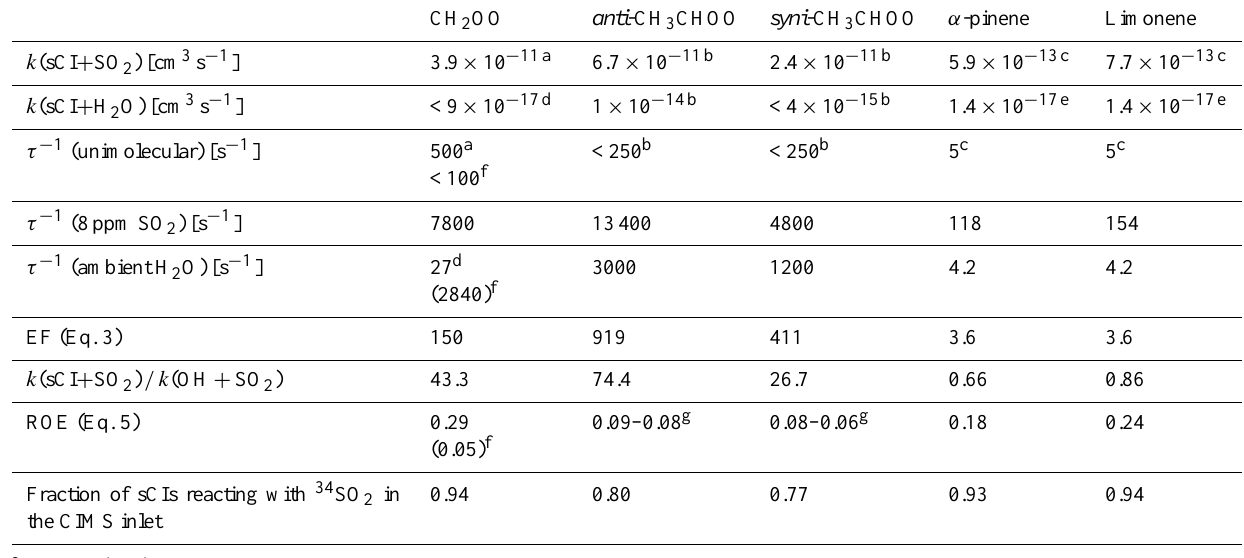
Table 2. Details of the calculation of the relative oxidation efficiency (ROE, see Eq. 5) for specific Criegee intermediates assuming ozonolysis of alkenes as their only source of formation for average ambient conditions at Mace Head (14 ◦ C, 75% RH, BG sig /OH sig = 1). CH 2 OO anti -CH 3 CHOO syni -CH 3 CHOO α